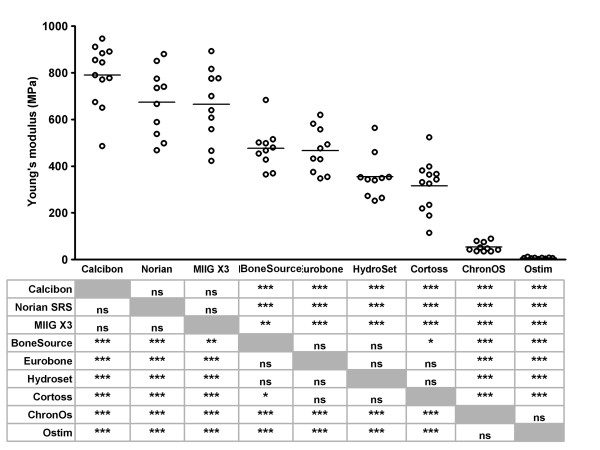
Young's modulus of bone substitutes The Young's modulus was determined using unconfined compression tests as described in the Materials and Methods. Each dot represents an individual test sample, and lines indicate the average value. The table below the figure shows the outcome of the pairwise comparisons (Student's T-test with Bonferroni correction). *, p < 0.05; **, p < 0.01; ***, p < 0.005; ns, not statistically significantly different. Grey boxes represent the self-self combinations, which could not be tested.